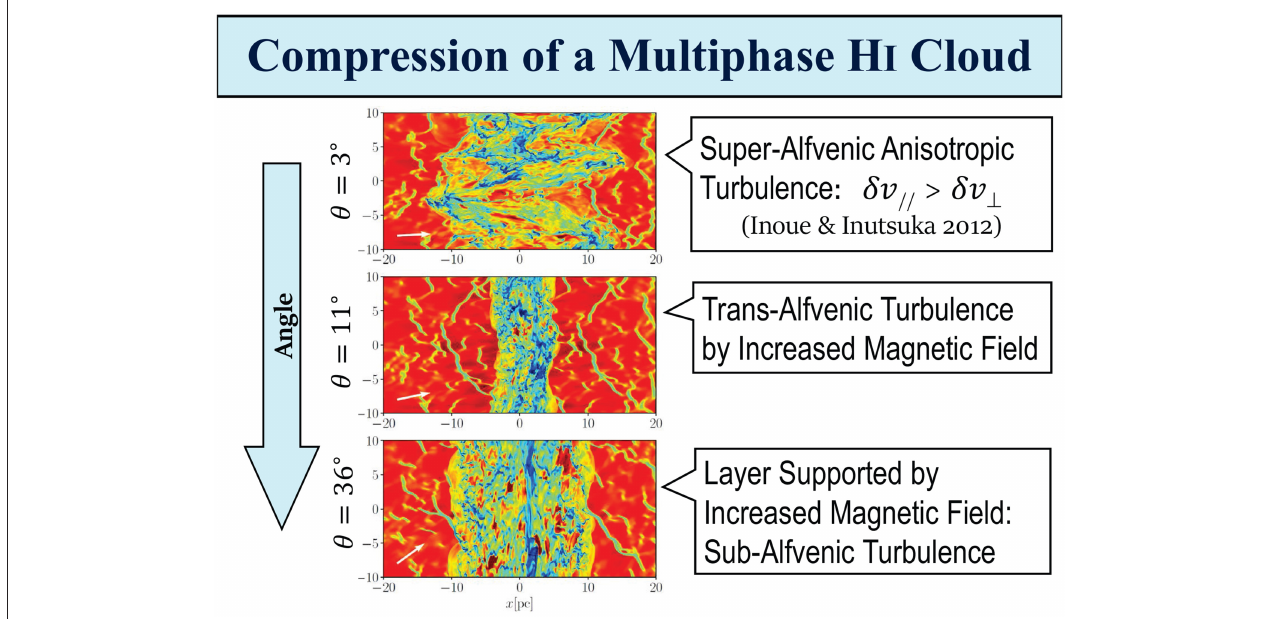
FIGURE 3 | The result of compression of multiphase HI clouds by shock waves (Iwasaki et al., 2018). The column density is shown (red stands for WNM while Blue-green represents CNM). The relative angle ( θ ) between the shock wave propagation direction and the mean magnetic field is 3 ◦ (Upper panel) , 11 ◦ (Middle panel) , and 36 ◦ (Lower panel) ,